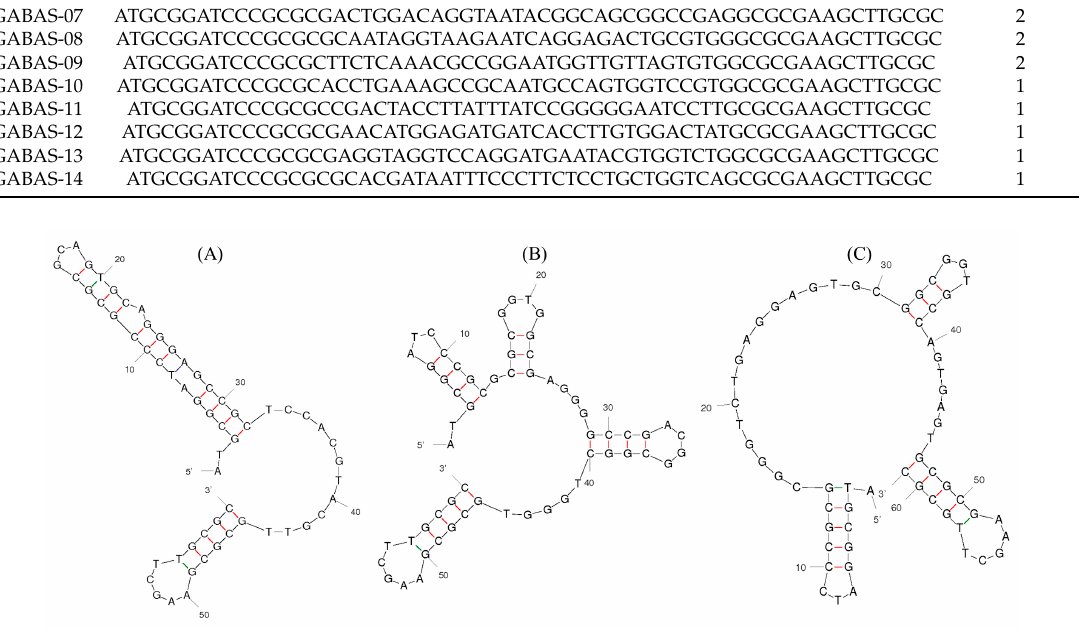
Figure Figure 1. The secondary structures of candidate aptamers: ( A ) GABAS-01, ( B ) GABAS-02, and ( C ) GABAS-03. Table 2. Aptamer sequences after screening with rGO-SELEX.